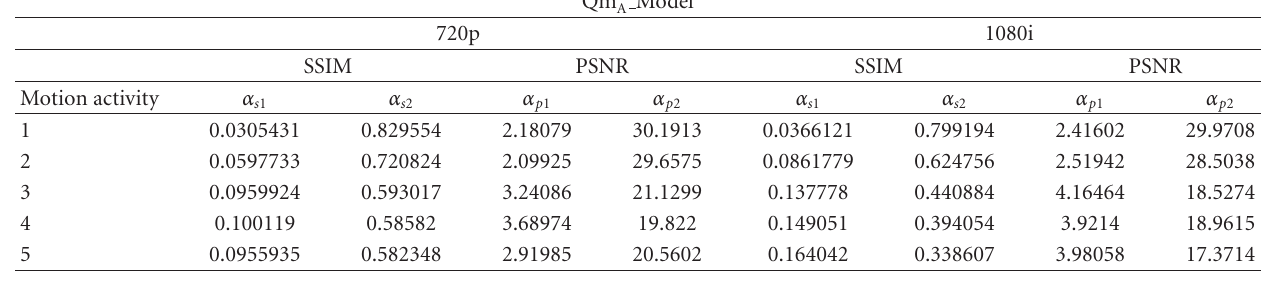
Table 3: Coe ffi cients for the model of Qm A .